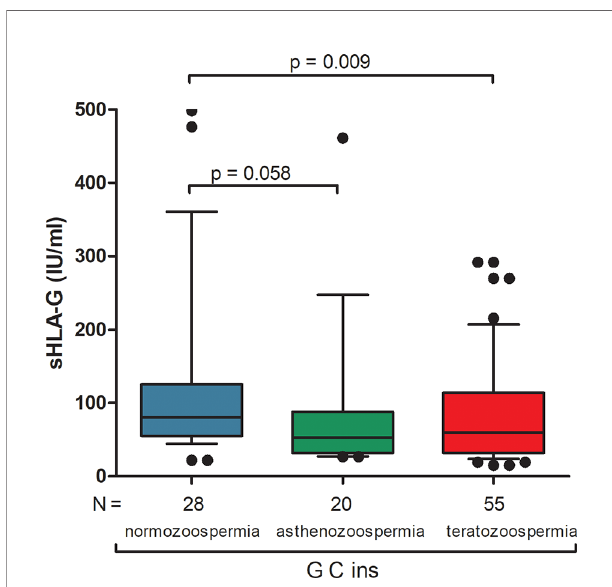
FIGURE 2 | Concentration of soluble HLA-G per milliliter of plasma (IU/ml) measured in semen samples of G-C-ins haplotype carriers. Haplotype was estimated in the following order: rs1632947: − 964G>A; rs1233334: − 725G>C/T; rs371194629:insATTTGTTCATGCCT/del. Blue box represents the level of sHLA-G measured in normozoospermic men, green box – in men with asthenozoospermia, red box – in men with teratozoospermia. Boxes are drawn from the fi rst quartile (25th Percentile) to the third quartile (75th Percentile). Black lines in boxes are medians. Whiskers represent 10-90 percentiles. N is the number of patients. P-values are calculated by Mann-Whitney